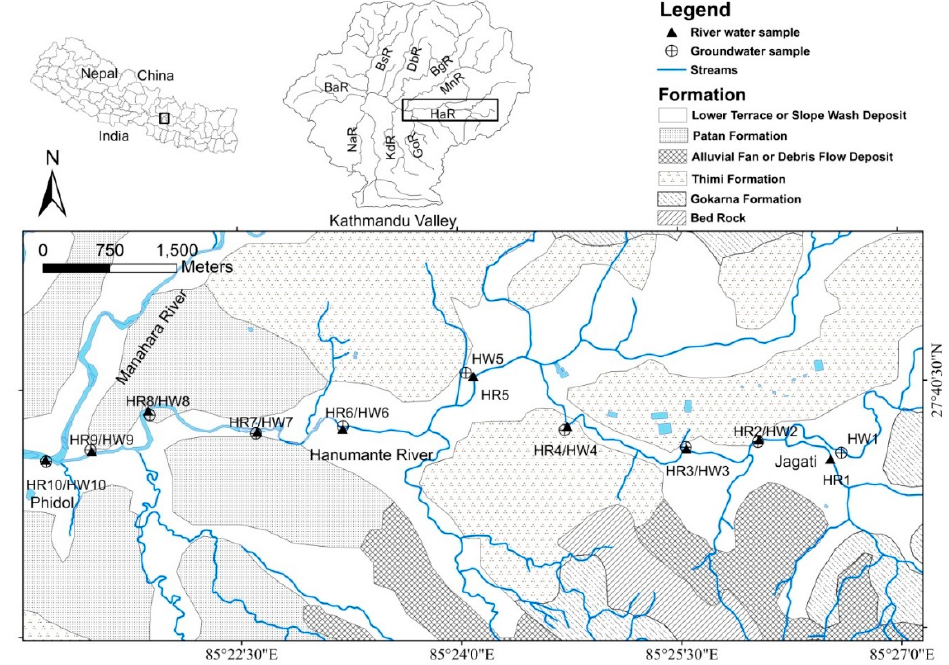
Figure 1. Sedimentological map showing study area and sampling locations along the Hanumante River corridor (modified from Yoshida and Igarashi [42], Sakai et al. [43], and Dhital [44]); BsR = Bishnumati, DbR = Dhobi, BgR = Bagmati, MnR = Manahara, HaR = Hanumante, GoR = Godawari, KdR = Kodku, NaR = Nakhhu, and BaR = Balkhu river.